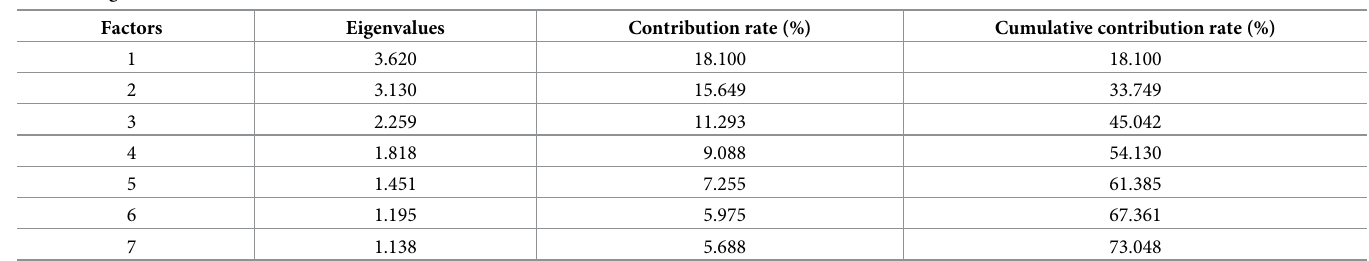
Table 4. Eigenvalues and contribution rate of main